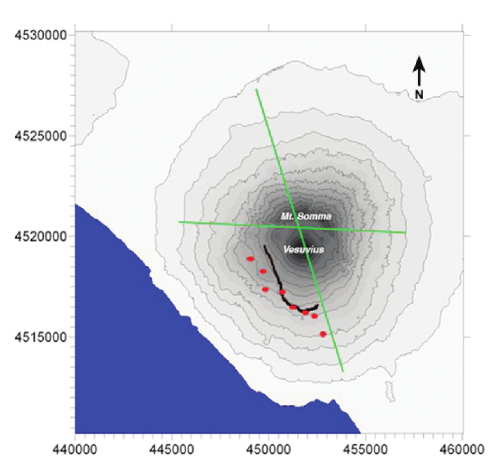
Fig. 1. Sketch map of the Vesuvius volcanic area. UTM coordinates are shown on both axes in figure. Red ellipses: CSAMT stations. Green lines: shallow DD ERT profiles. Black curved line: near-surface ERT